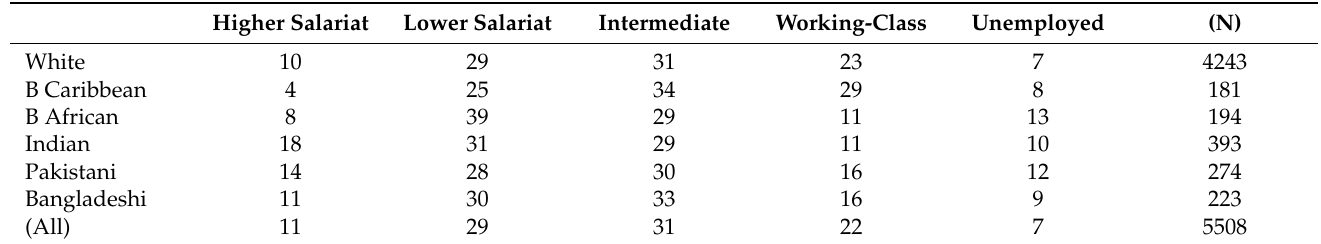
Table 6. Distribution of labour market position by ethnicity for the economically active (percentage by row).